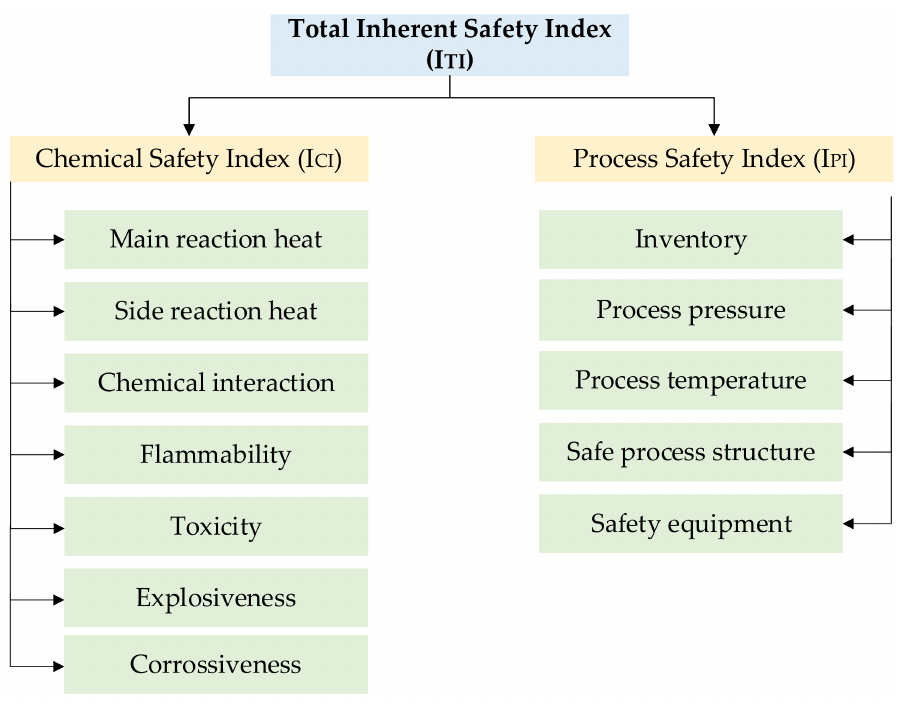
Figure 5. Criteria used to calculate I CI and I PI .